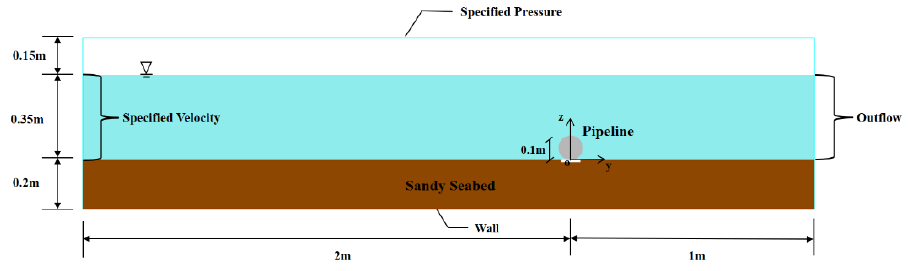
Figure 1. Sketch of numerical model setup. Table 2. Cases for mesh sensitivity analysis.